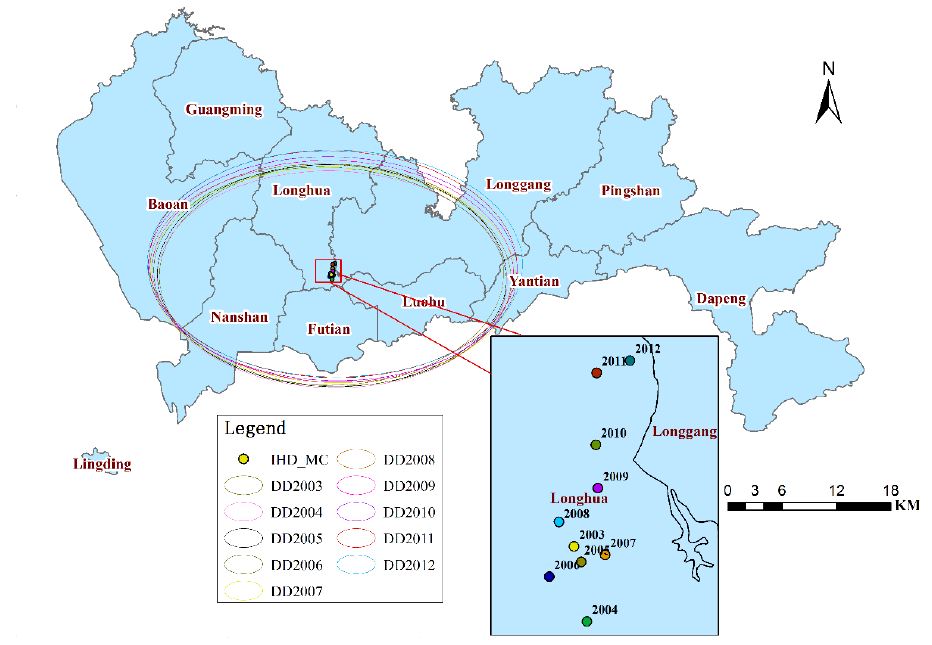
Figure 9. Annual mean center and directional distribution of IHD in Shenzhen from 2003 to 2012.